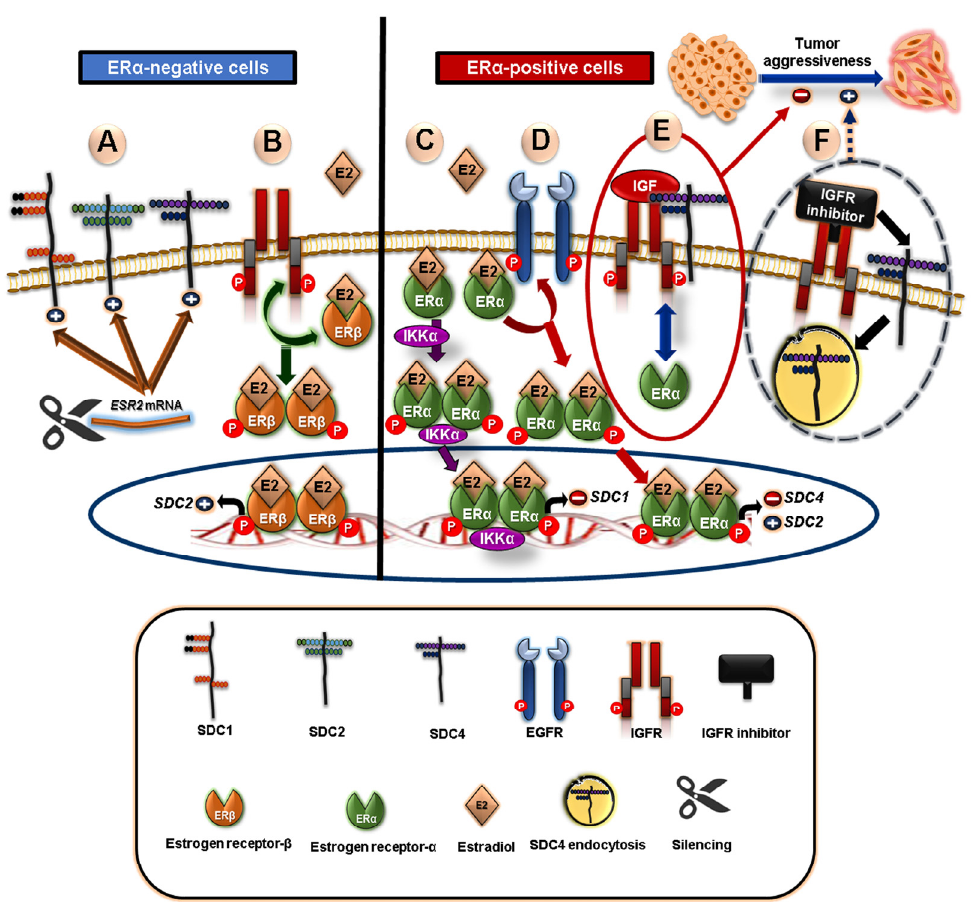
Figure 2. Schematic diagram showing the possible crosstalk between syndecans (SDCs) and estrogen receptors (ER) in breast cancer cells. In ER α -negative cells, ( A ) silencing of ESR2 in MDA-MB-231 breast cancer cells induces the expression of SDC1 , 2 , and 4 , and ( B ) estradiol (E2)-induced SDC2 expression depends on IGFR signaling crosstalk. In ER α -positive cells, ( C ) ER α activation by E2 in IKK-dependent mechanisms enhances ER α stability and transcriptional activity, leading to SDC1 repression, ( D ) EGFR mediates E2 inhibitory action on SDC4 expression and E2-induced SDC2 expression, ( E ) IGFR inhibits aggressiveness of ER α -dependent MCF-7 by sustaining the expression of SDC4 , and ( F ) IGFR colocalizes with SDC4, and that IGFR blocking results in SDC4 endocytosis and aggressiveness phenotype.